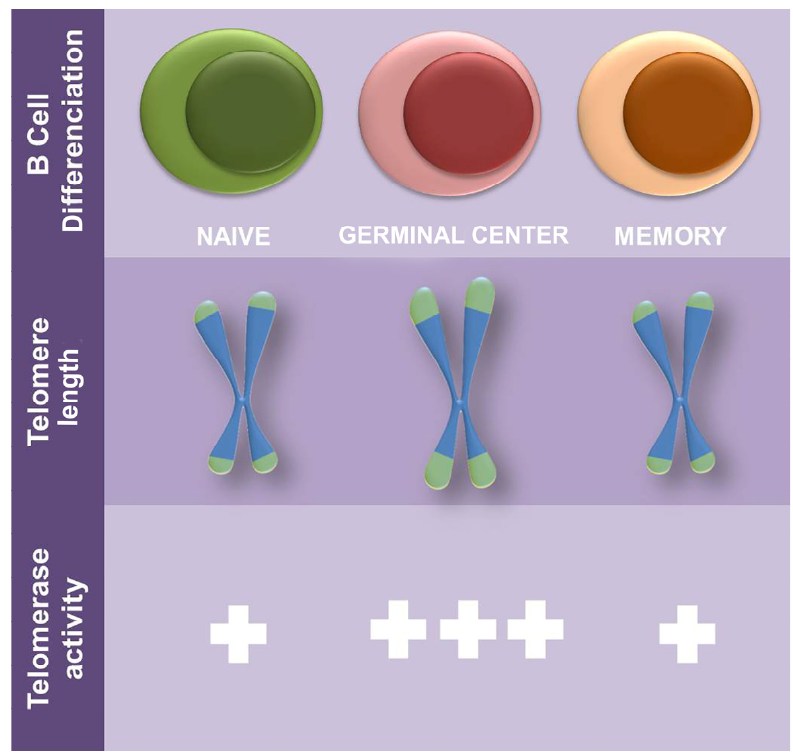
Figure 2. Model of telomere regulation in B cells. The green color represents telomere length and the blue color the chromosomes. The germinal center has greater telomere length than naive and memory cells.